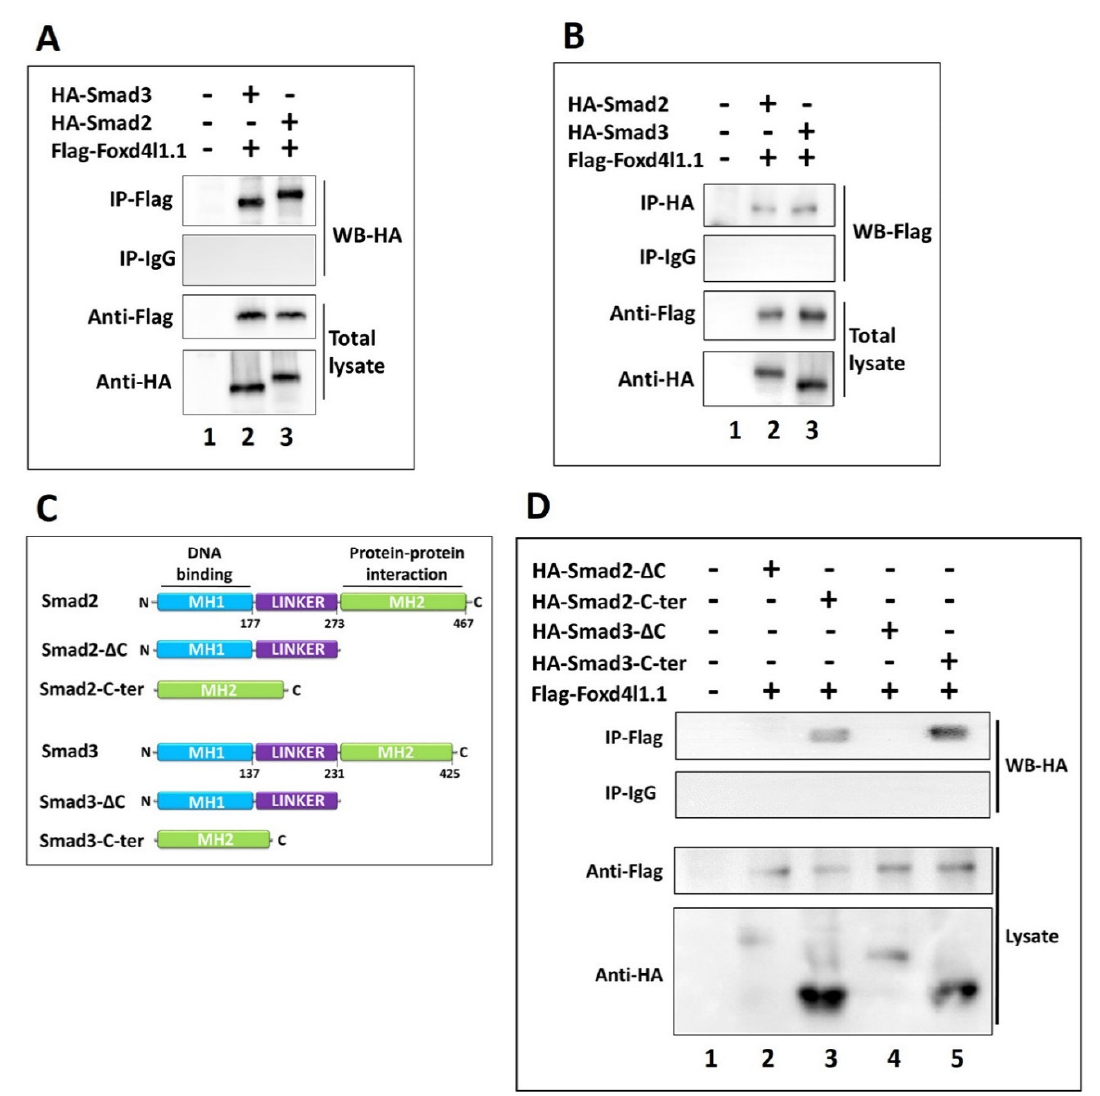
Figure 4. Foxd4l1.1 physically interacts with C -terminal domain of Smad2 and Smad3 proteins: ( A , B ) co-immunoprecipi- tation (Co-IP) assay was performed to examine the interaction of Flag-Foxd4l1.1 and HA-Smad2/3 recombinant proteins: ( A ) Co-IP was performed with an anti-Flag antibody, followed by Western blotting (WB) with anti-HA antibody; ( B ) Co- IP was performed with anti-HA antibody, followed by WB with anti-Flag antibody; ( C ) schematic representation of trun- cated Smad2 and Smad3 constructs; these include Smad2/3- Δ C, having the C -terminal domain deleted, and Smad2/3-C- ter, containing only the C -terminal domain of the original parental protein; ( D ) co-immunoprecipitation (Co-IP) assay was performed to examine the interaction between Flag-Foxd4l1.1 and HA-Smad2- Δ C, HA-Smad3- Δ C, HA-Smad2-C-ter, and HA-Smad3-C-ter. Co-IP was performed with anti-Flag antibody, followed by WB with anti-HA antibody.